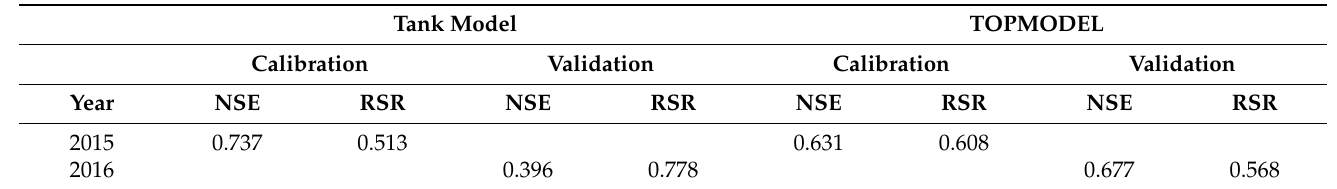
Table 3. A comparative performance of tank model and TOPMODEL during model calibration and validation periods. Years 2015 and 2016 were used for model calibration and validation respectively.